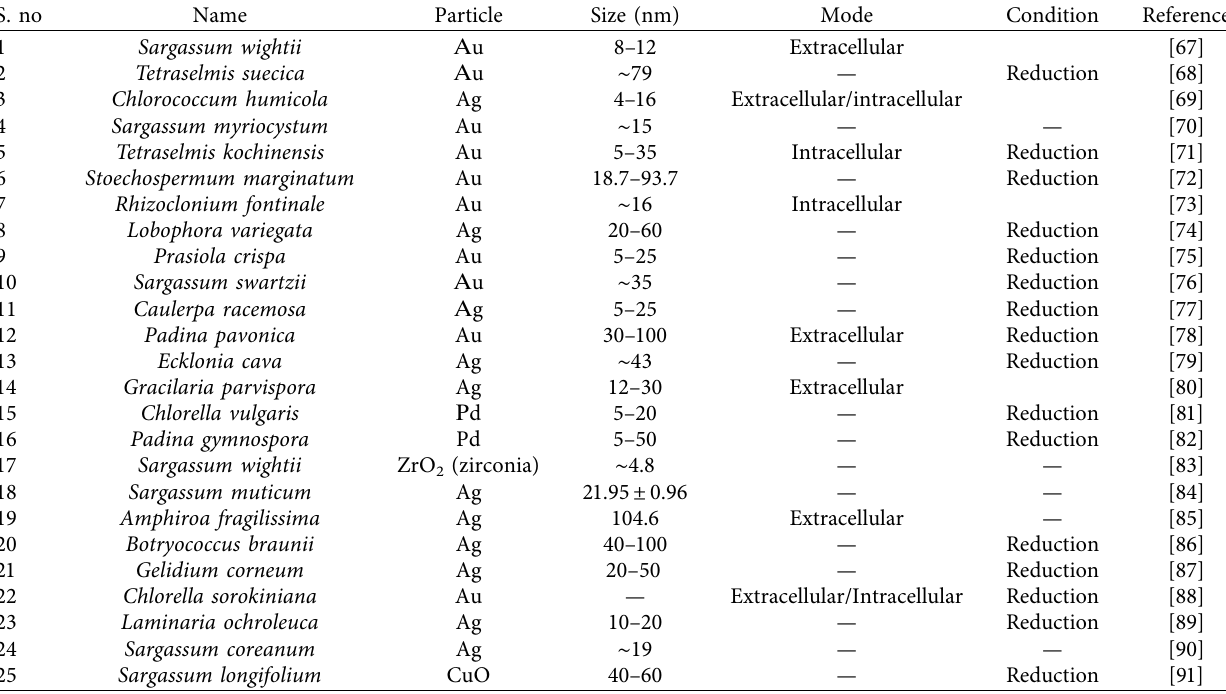
Table 2: Algae-synthesized